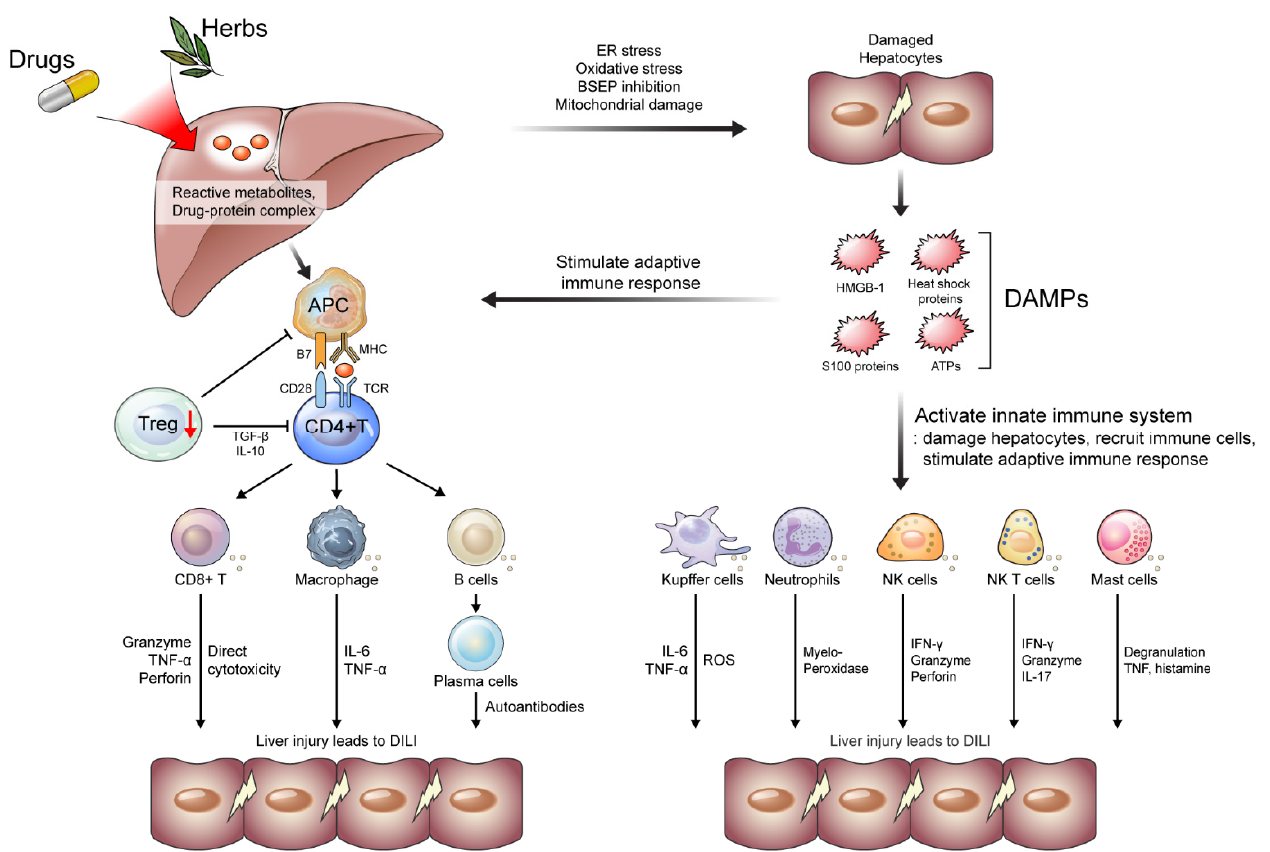
Figure 1. Mechanisms of the development of drug-induced liver injury (DILI). Reactive metabolites or drug–protein complex causes ER and oxidative stress in hepatocytes. BSEP inhibition and mito- chondrial damage also damage hepatocytes, leading to the secretion of DAMPs, including HMGB-1, heat shock proteins, S100 proteins, and ATPs. DAMPs activate innate immune systems and stimulate immune response. Activated innate immune systems (e.g., Kupffer cells, neutrophils, NK cells, NK T cells, and Mast cells) damage hepatocytes, recruit immune cells, and stimulate adaptive immune response. Reactive metabolites or drug–protein complexes are presented by APCs, which lead to activation of adoptive immune response (e.g., T cells and B cells) along with the stimulation of APCs by DAMPs. Meanwhile, Treg cells decrease and fail to maintain immune tolerance. APC, antigen presenting cells; ATPs, adenosine triphosphate; BSEP, bile salt export pump; DAMP, damage-associated molecular patterns; ER, endoplasmic reticulum; HMGB, high-mobility group box; IFN, interferon; IL, interleukin; NK, natural killer; TNF, tumor necrosis factor; Treg, regulatory T cells.